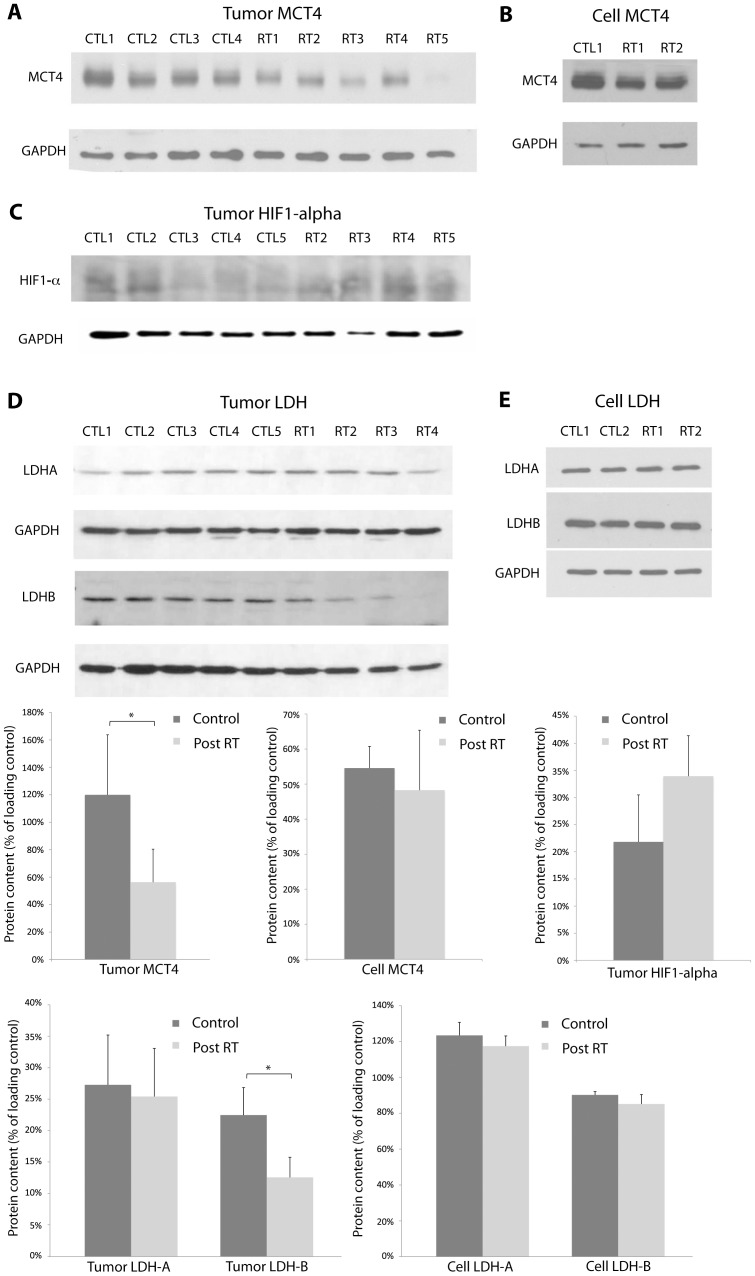
Western blot analysis was used to assess cell membrane monocarboxylate transport and lactate dehydrogenase levels.Tissue hypoxia in the tumors was also assessed by HIF1-α expression. A) Western blots showed a decrease in MCT4 expression in MDA-MB-231 tumors radiation treated with radiation as compared to controls. The difference was significant (* P<0.03). B) A small decrease in MCT4 expression was observed in treated MDA-MB-231 cells in vitro. C) HIF1-α expression was higher for the treated tumors, but the difference was not significant. D) Expressions of lactate dehydrogenase isoforms B were significantly lower in treated tumors. E) Little changes were found for expressions of LDH-A and LDH-B in treated and control cells. GAPDH was used as a loading control.